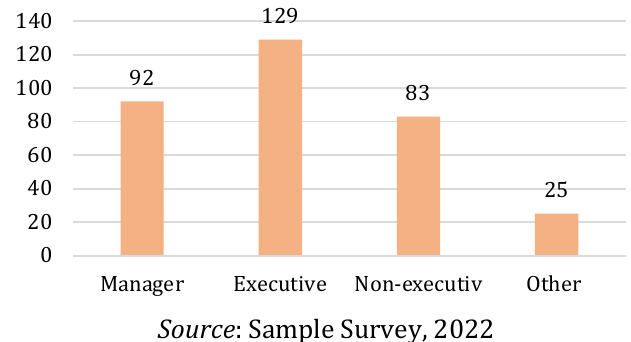
Figure 4: Composition of respondents’ level of employment